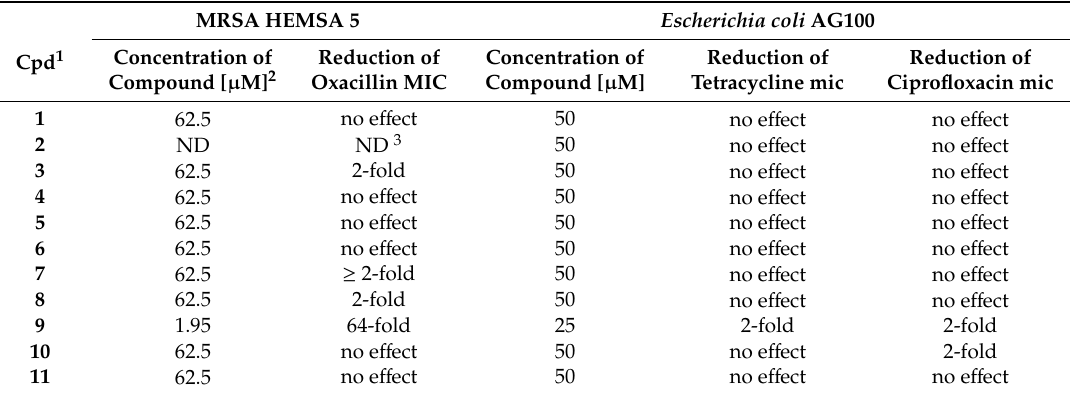
Table 3. Numerical value of the reduction of the MICs of selected antibiotics in methicillin resistant S. aureus (MRSA) or in E. coli AG100 exerted by selenocompounds when administered in combination with antibiotics.